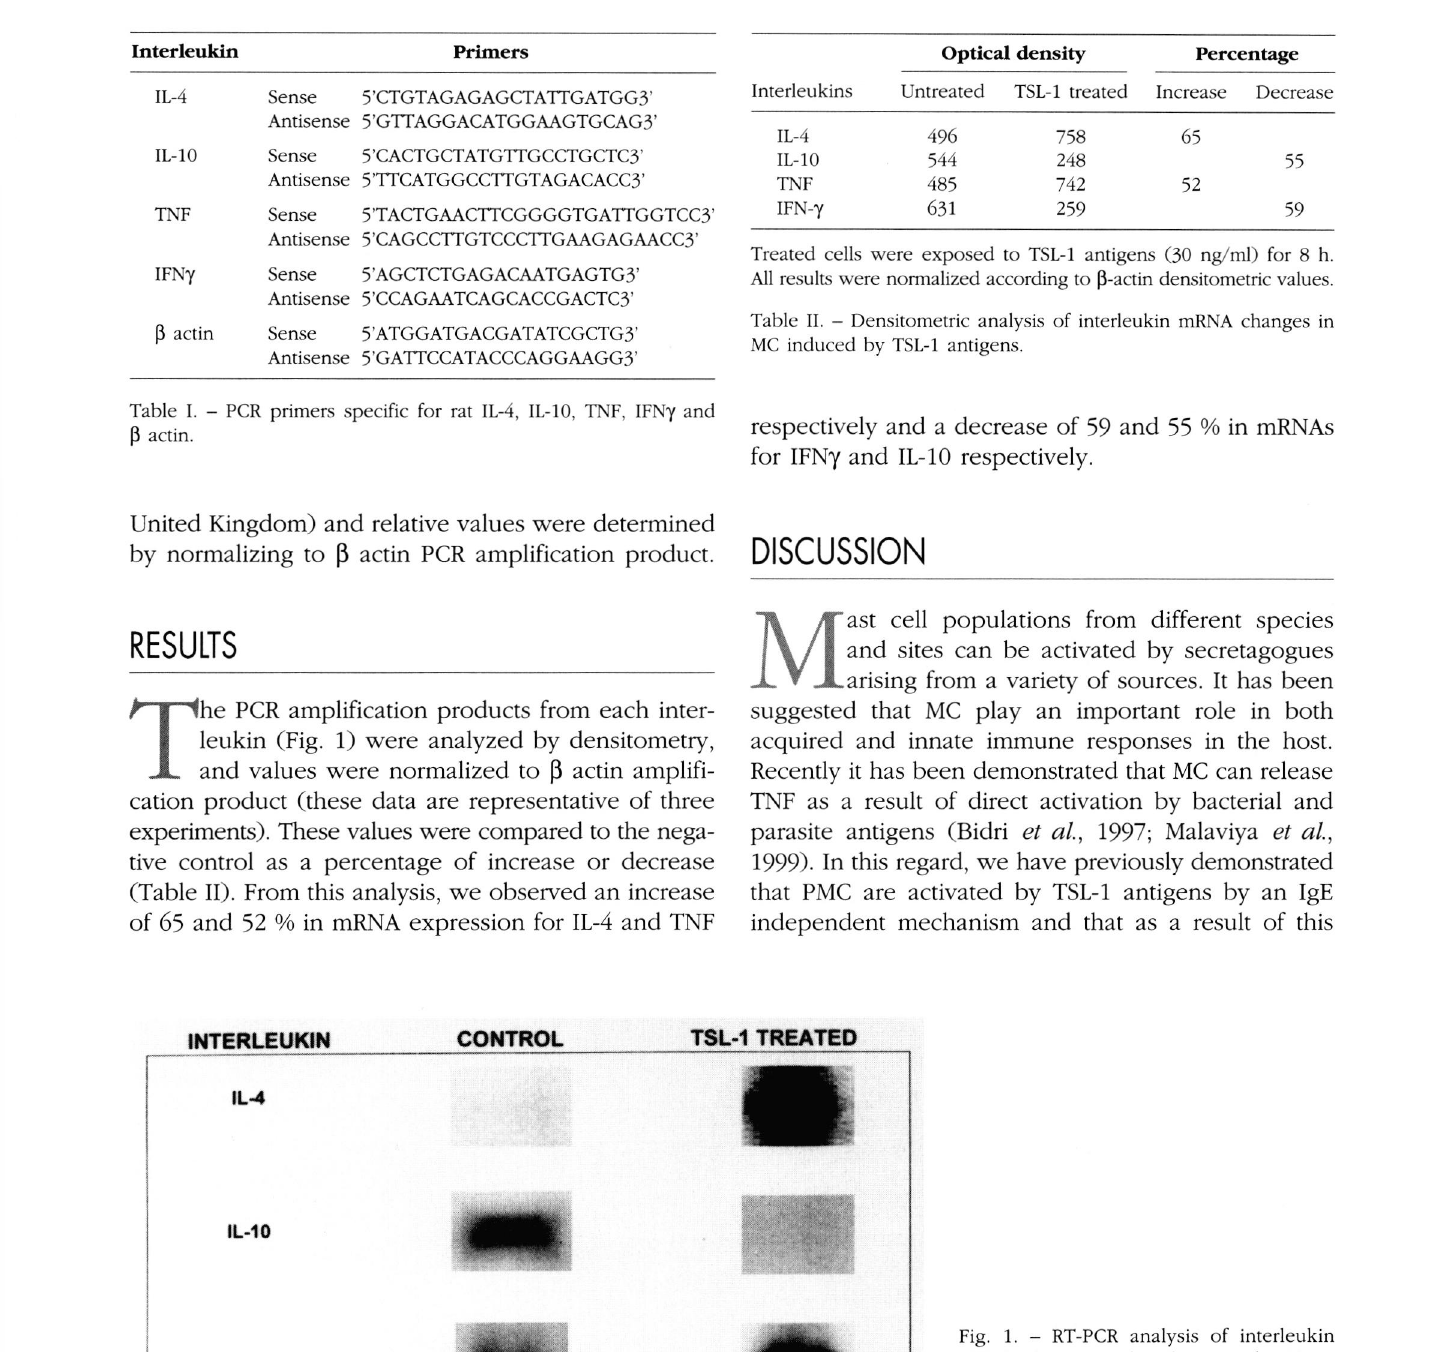
Fig. 1. - RT-PCR analysis of interleukin mRNA changes induced in MC by TSL-1 antigens.